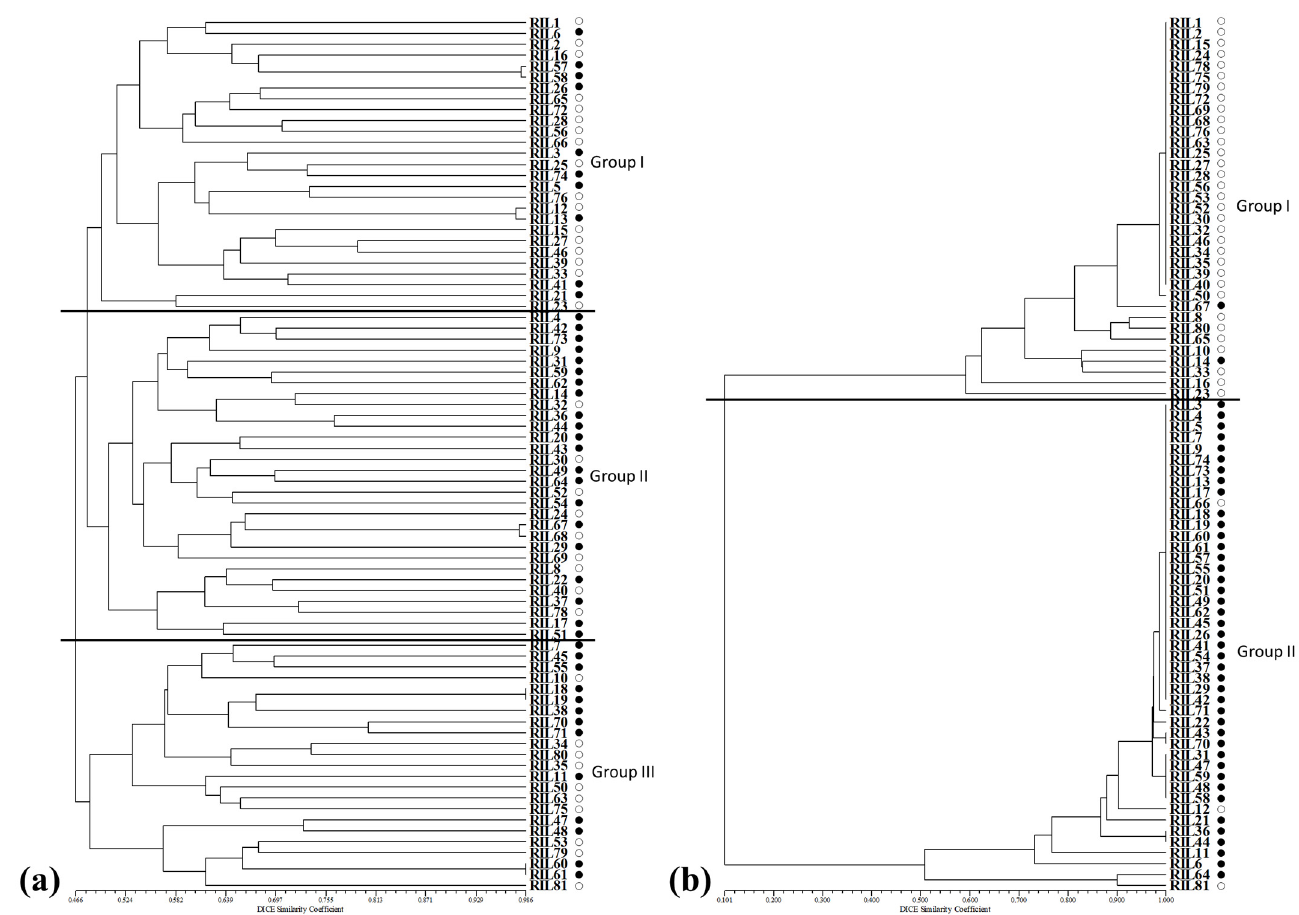
Figure 3. UPGMA dendrogram in maize 80 RIL population and ( a ) 14,968 markers, ( b ) 40 markers by PCA-MLM analysis. ○ : low-amylose lines, ● : high-amylose lines.